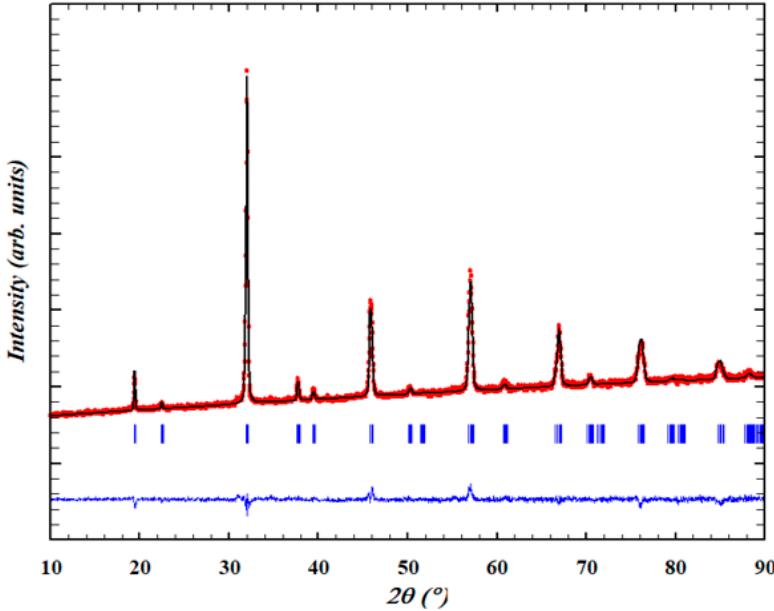
Figure 1. Calculated (black) vs. experimental (red) powder X-ray diffraction pattern for Sr 2 NiTeO 6 .